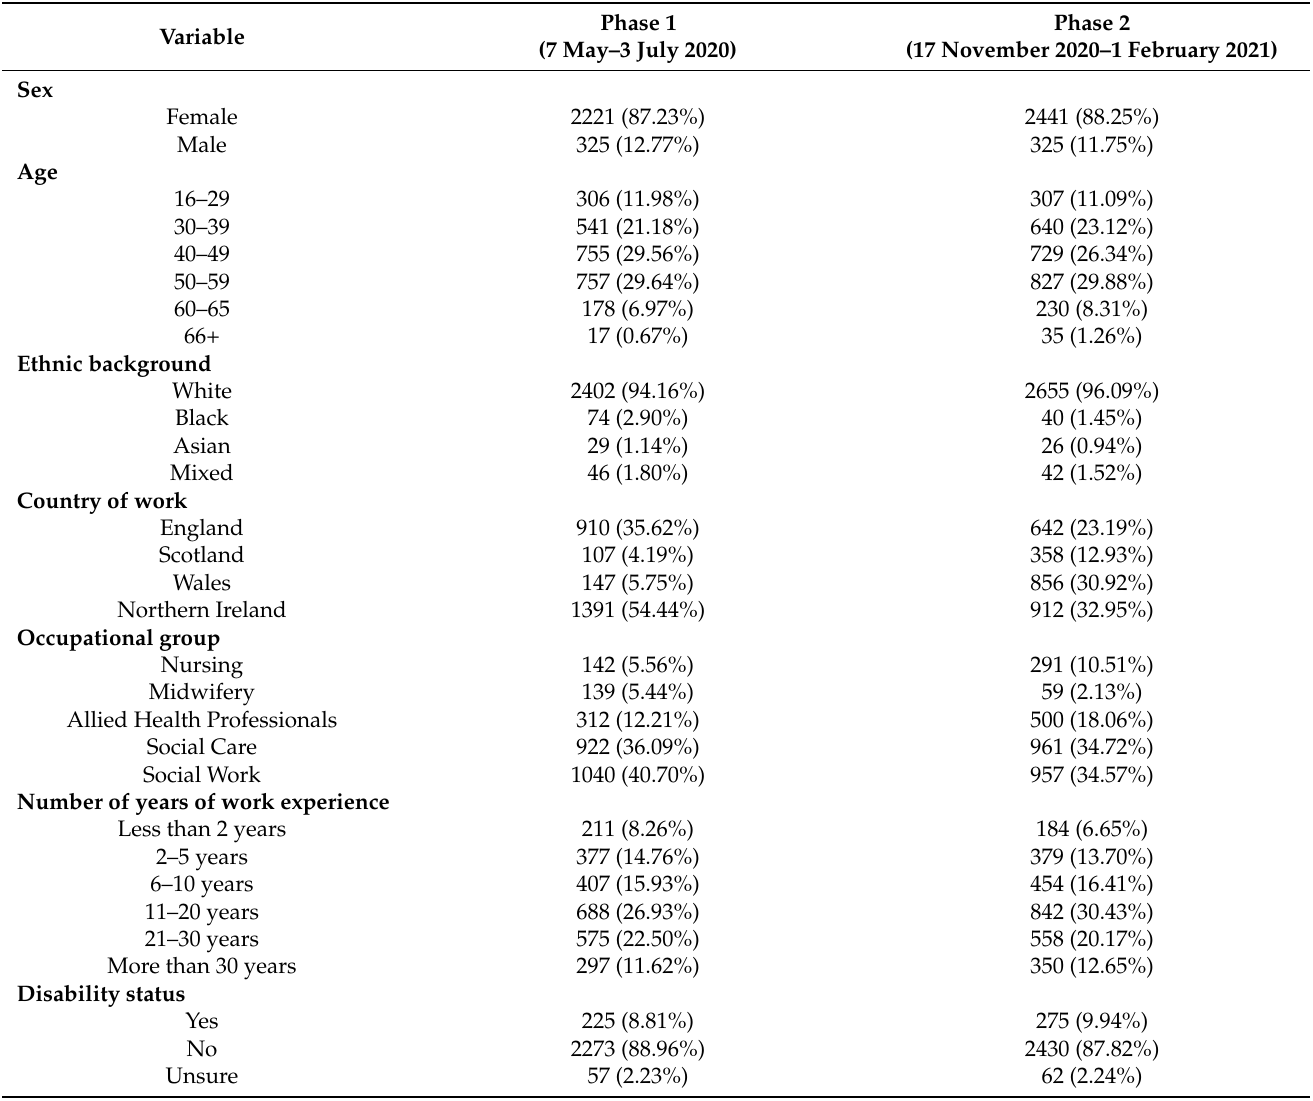
Table 1. Demographic and work-related characteristics of the effective sample (Phase 1: n = 2555; Phase 2: n = 2768).